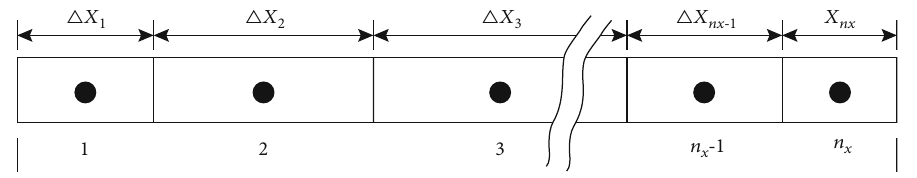
Figure 4: Block-centered network for 1D in the x -direction.